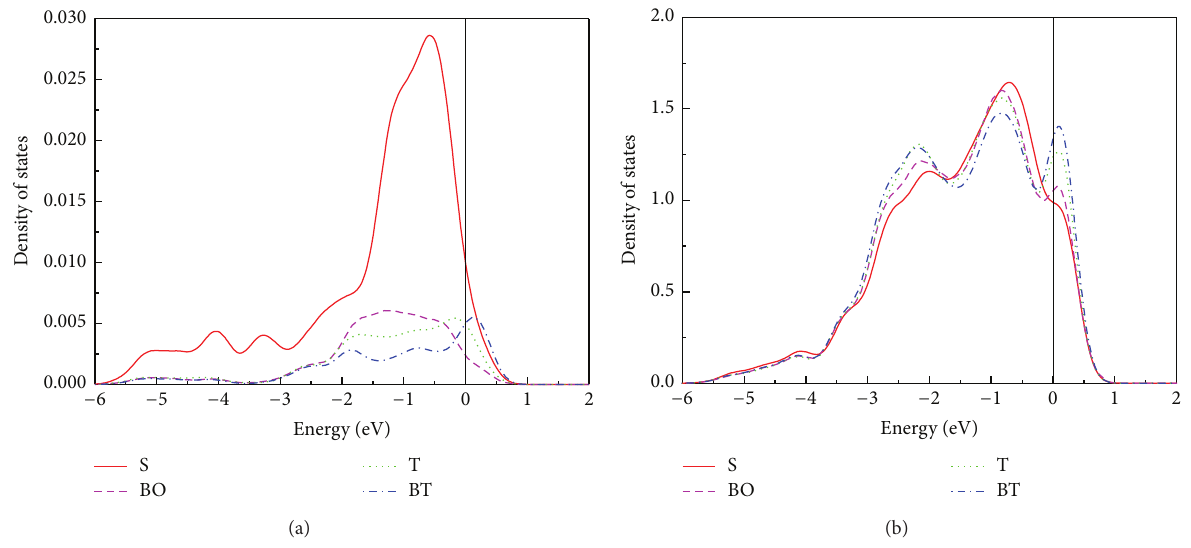
Figure 2: Total DOS of (a) an interstitial He atom at various positions and (b) its NN-Zr atoms (vertical line is the Fermi level 𝐸 𝐹 ).